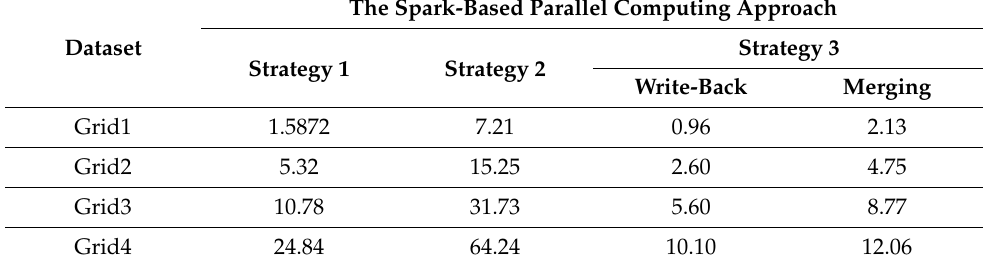
Table 4. The time spent on the three strategies (time unit: min).